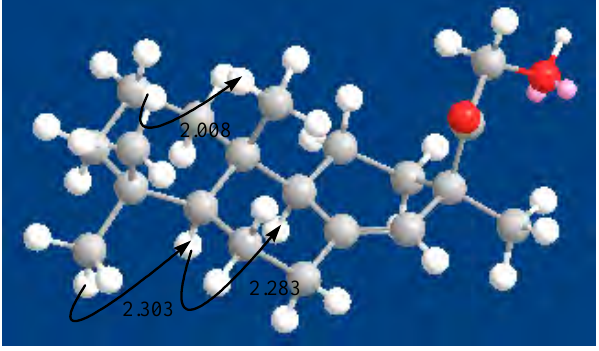
2.2832.008 2.303